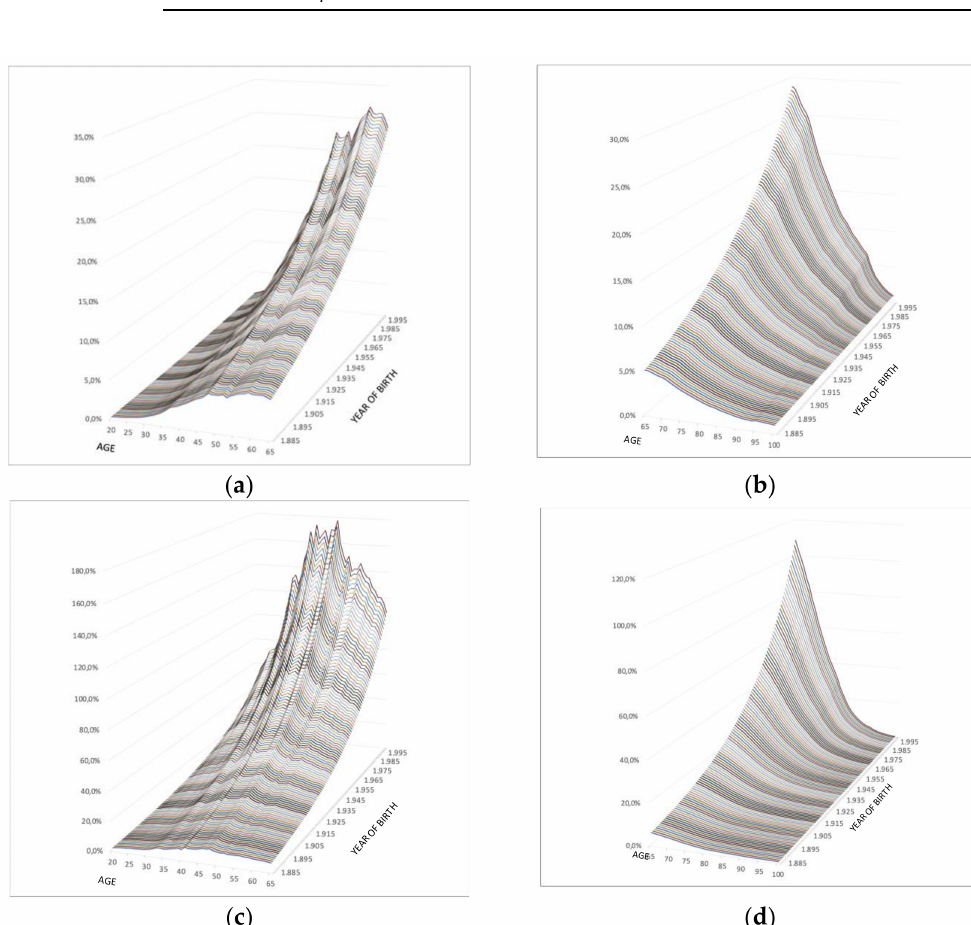
Figure 2. Increase in the mortality rate due to dependence in Spain. Evolution by gender and age: ( a ) Men, period of work activity from the age of 20 to the age of 65, according to year of birth; ( b ) Men, period of retirement from the age of 65 and until the beneficiaries’ death, according to year of birth; ( c ) Women, period of work activity from the age of 20 to the age of 65, according to year of birth; ( d ) Women, period of retirement from the age of 65 and until the beneficiaries’ death, according to year of birth. Source: Own